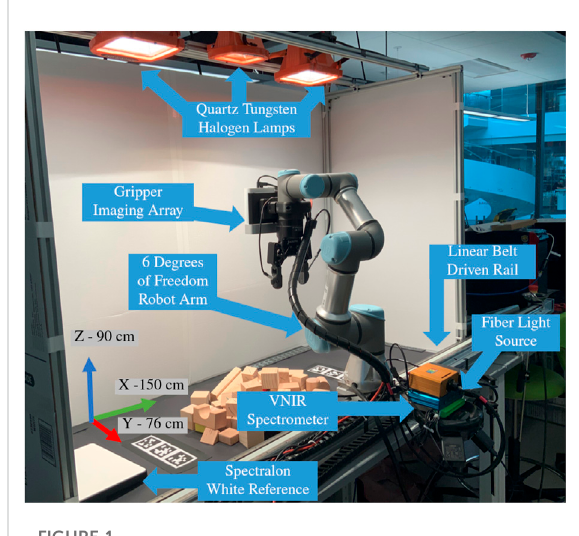
FIGURE 1 Test bed architecture used to acquire and register multiple Visible Near-Infrared (VNIR) hyperspectral scans for analysis. Note the axes orientations and workspace